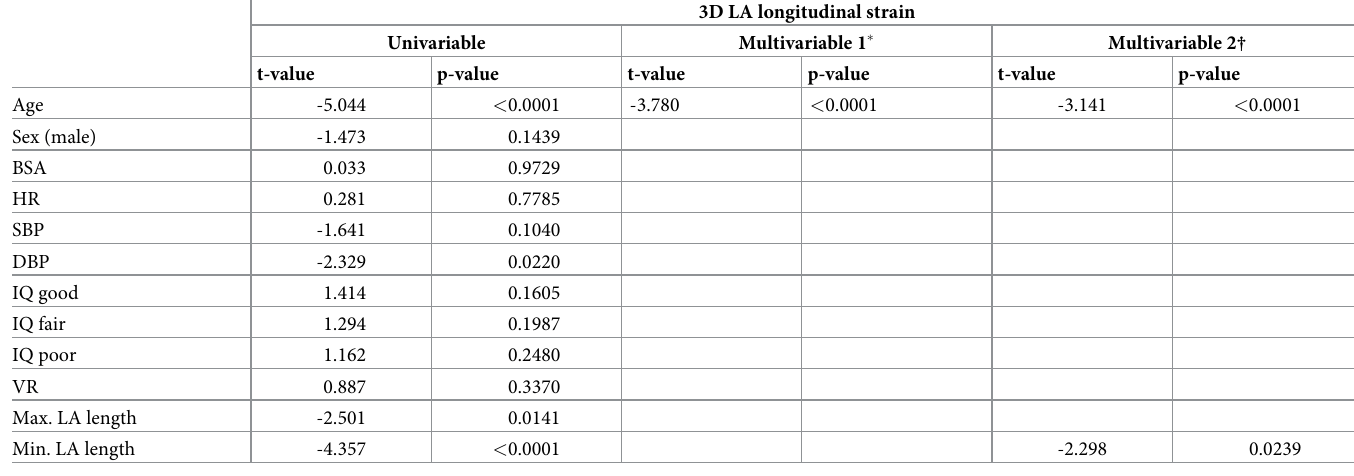
Table 3. Univariable and multivariable linear regression analysis for the association of left atrial longitudinal strain assessed with 3D echocardiography in 94 nor- mal